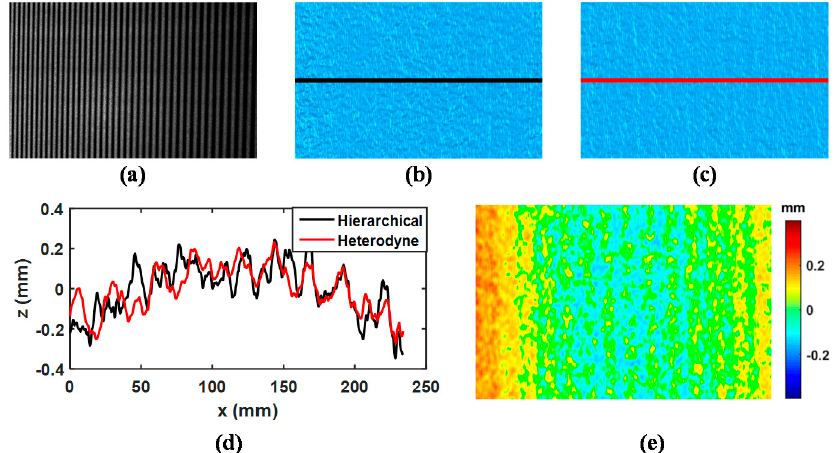
Figure 6. The measurement of a standard plane in the first position. ( a ) The one of the captured fringe; ( b ) 3D reconstruction result of the hierarchical method; ( c ) 3D reconstruction result of heterodyne method; ( d ) 3D measurement data of the same cross-section on the plane as shown in ( b , c ) with black and red lines, respectively. The z coordinate is the value of 3D measurement data minus the fitting line; ( e ) Measurement errors of the plane from data analysis as shown in ( b ).